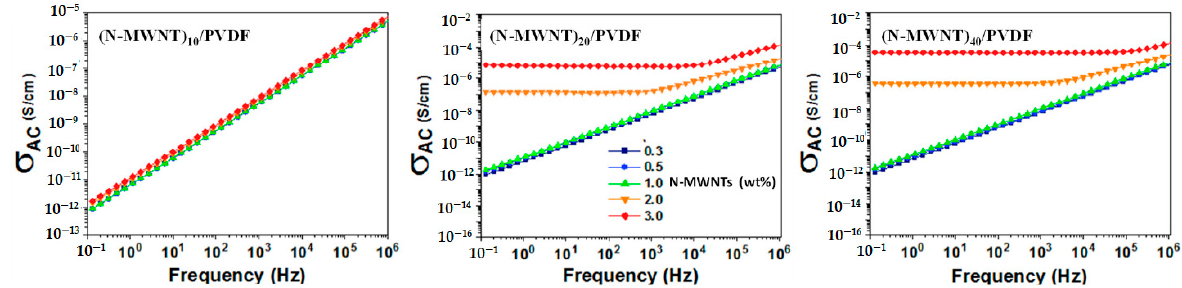
Figure 11. AC electrical conductivity as a function of frequency for PVDF nanocomposites containing N-MWNTs synthesized with catalyst concentration of Fe catalyst.